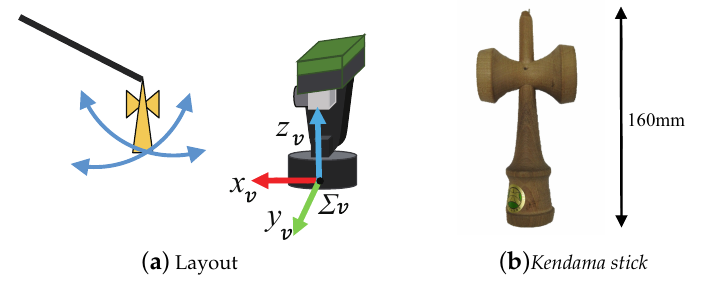
Figure 7. Experimental